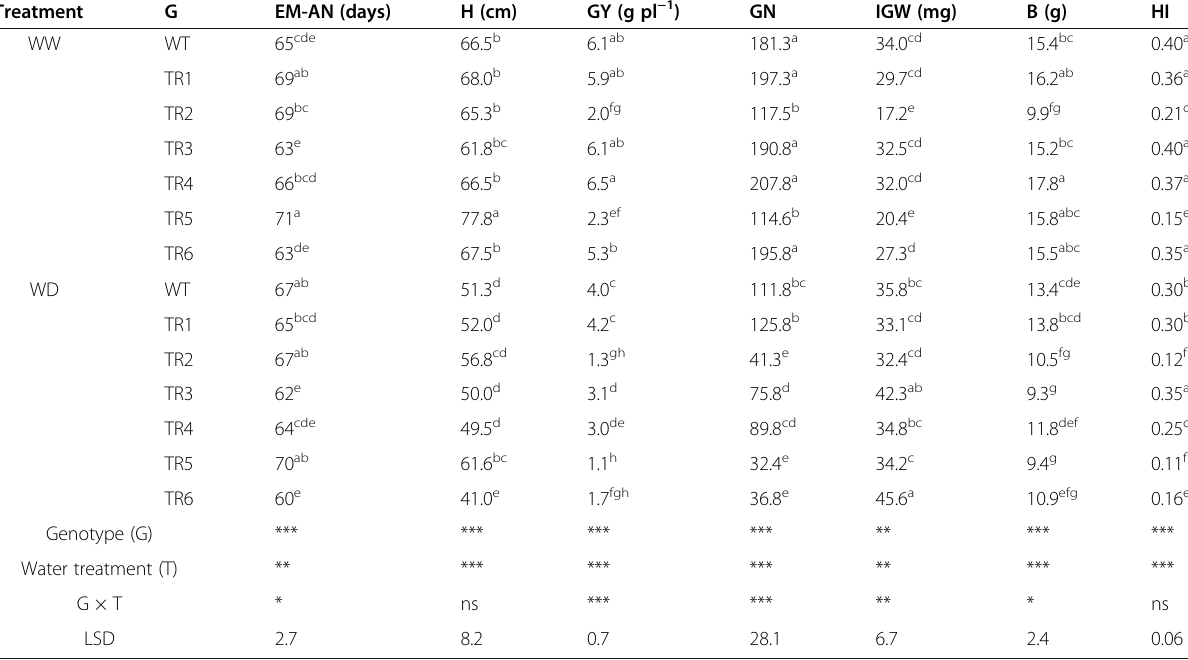
Table 1 Agronomic traits of the WT and transgenic events in the growth chamber